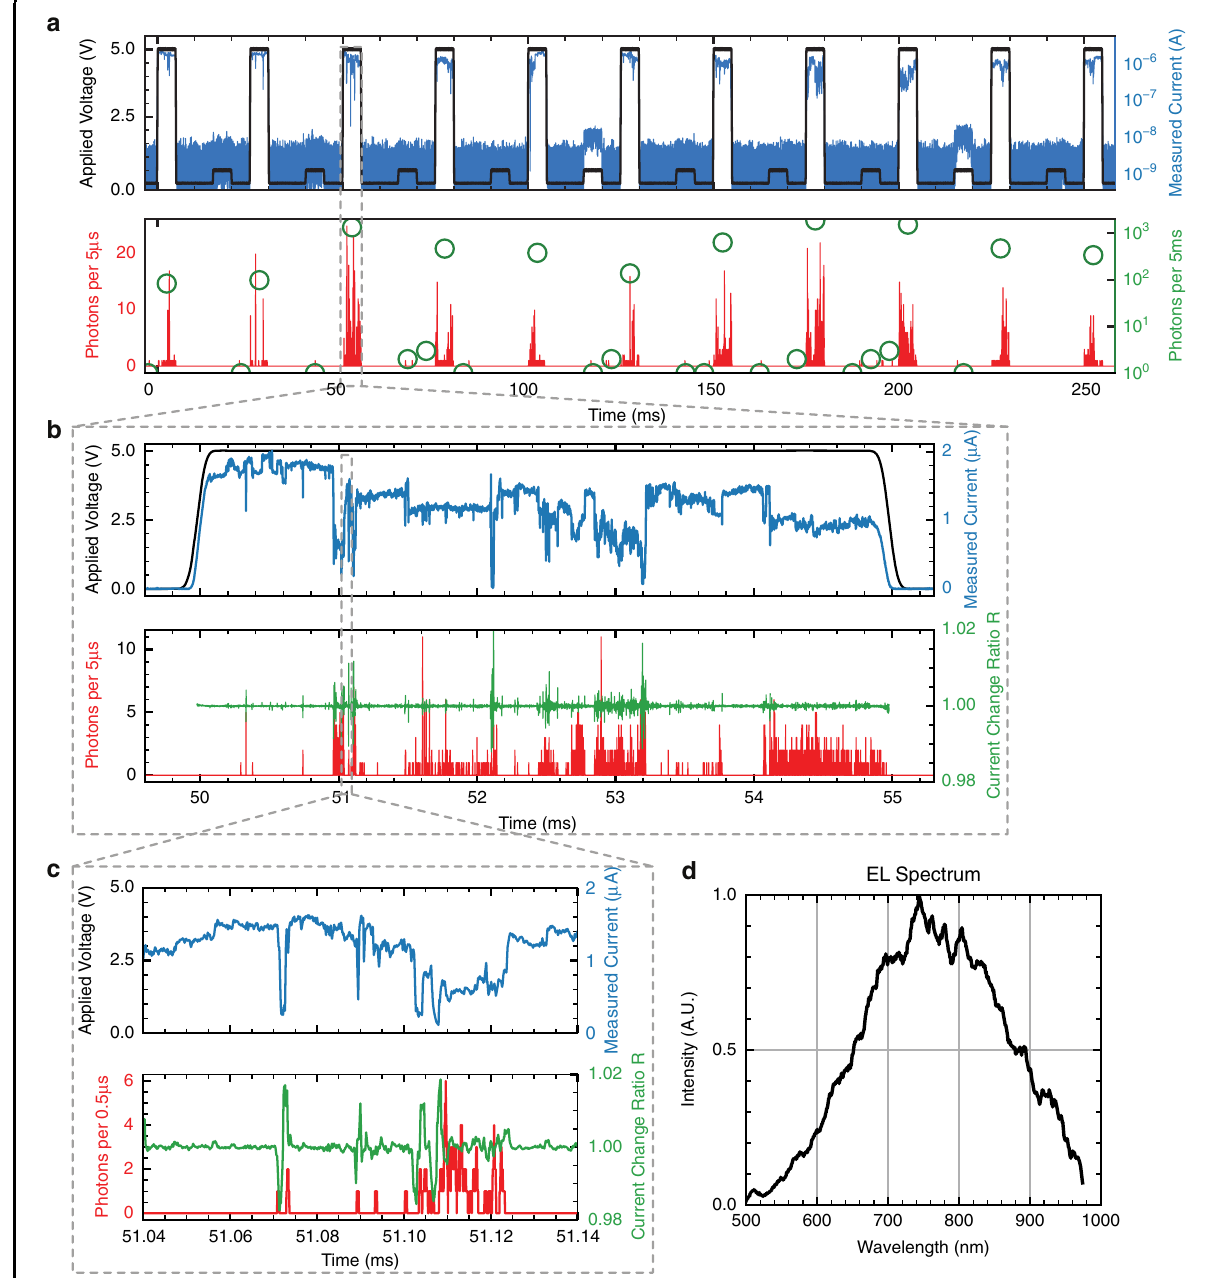
Fig. 3 APS Electroluminescence Pulse Measurement. a Upper panel: A series of alternating 5 V, 5 ms and 0.5 V, 5 ms pulses is applied to the APS. The measured current is shown on the right axis. Lower panel: Corresponding photon counts. Left axis (black bars), photon counts are binned every 5 µs. Right axis (green circles), photon counts are binned every 5 ms. b Upper panel: zoomed-in plot of one of the pulses (encircled in grey) from a. Lower panel left axis: photon counts are binned every 1 µs. Lower panel right axis: the current change ratio R = I t ⁄ I t- Δ t . A moving average window of 1 µs is applied to R to reduce the noise. c Zoomed-in plot of b. Photon counts are binned every 0.5 µs. A moving average window of 1 µs is applied to R to reduce the noise. d Measured EL spectrum with a series of 5 V, 5 ms pulses. The QE of the whole optical path including the spectrometer has been